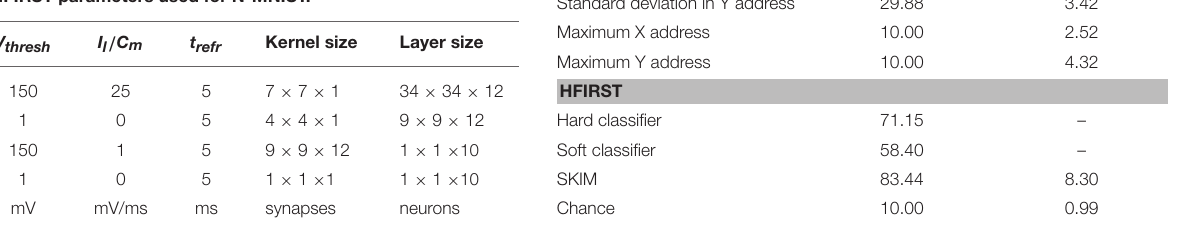
TABLE 3 | HFIRST parameters used for N-MNIST.